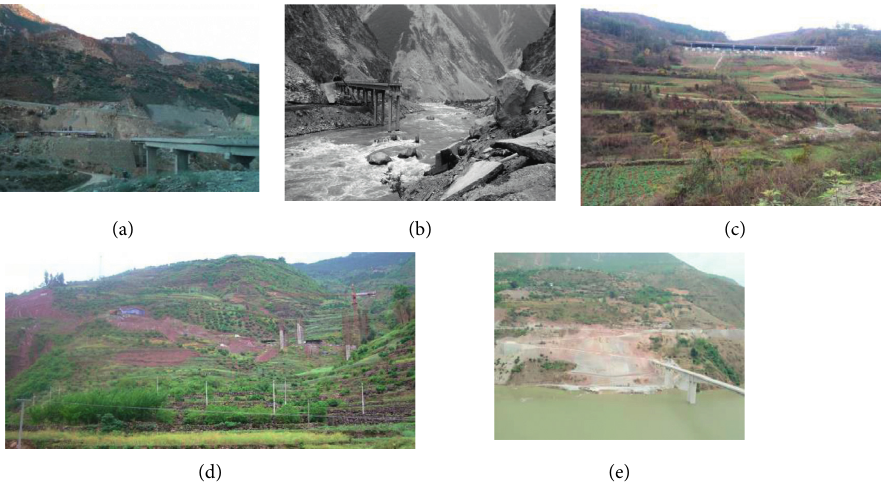
Figure 1: Typical case. (a) Dongla Bridge (Gang Luo et al. [13]). (b) Chediguan Bridge. (c) Zhengjiawan Bridge. (d) Qianping Bridge. (e) Lancang River Bridge. Table 1: Bridge-landslide parallel system. Diagram of the relative position of the bridge and the sliding surface Top